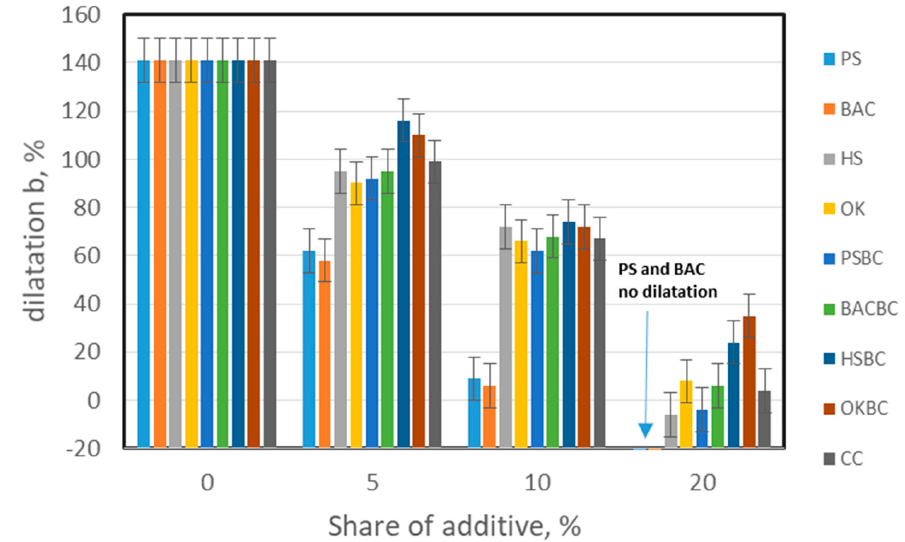
Figure 6. Influence of type and share of bio-components on dilatation.